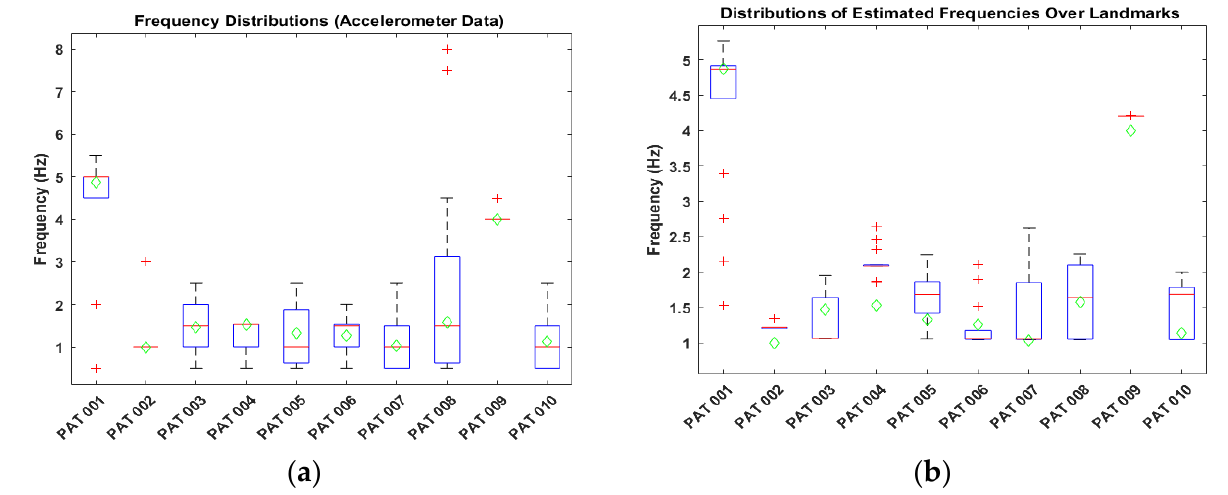
Figure 5. Frequency distributions. ( a ) Distribution of the accelerometer signals (15 frequency calculations were used for each patient). ( b ) Distribution of the video data over all landmarks (frequency calculations of 21 landmarks were used for each patient). Green diamonds correspond to the accelerometer’s calculated dominant frequency.